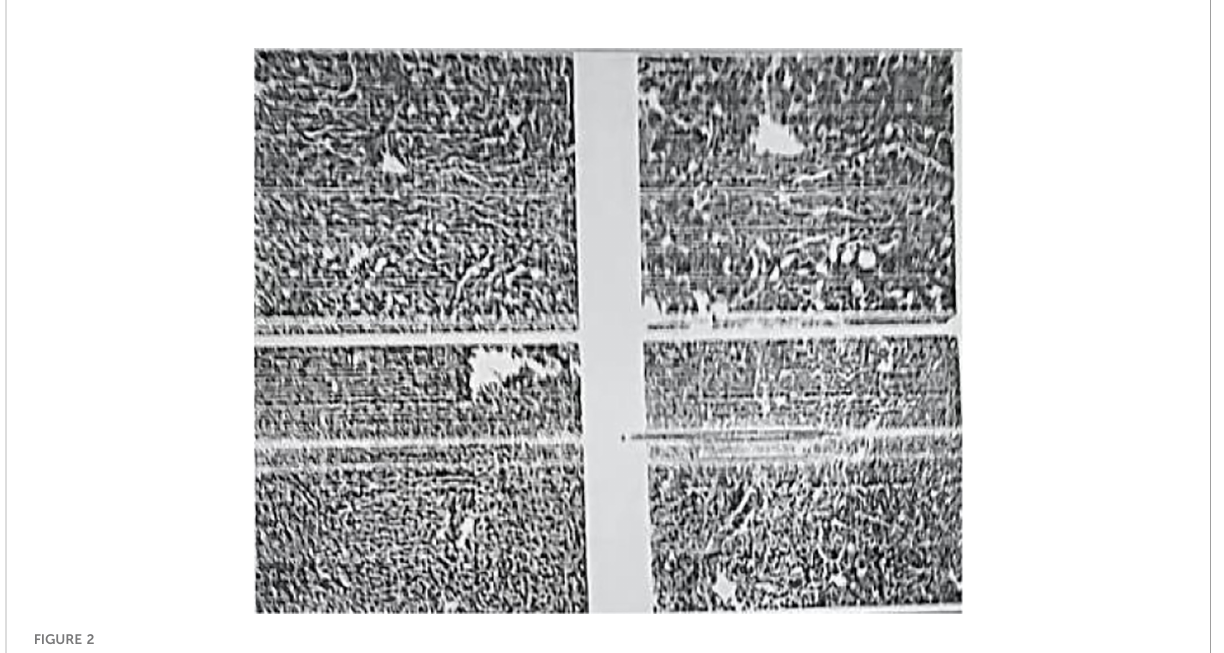
FIGURE 2 Postoperative pathology